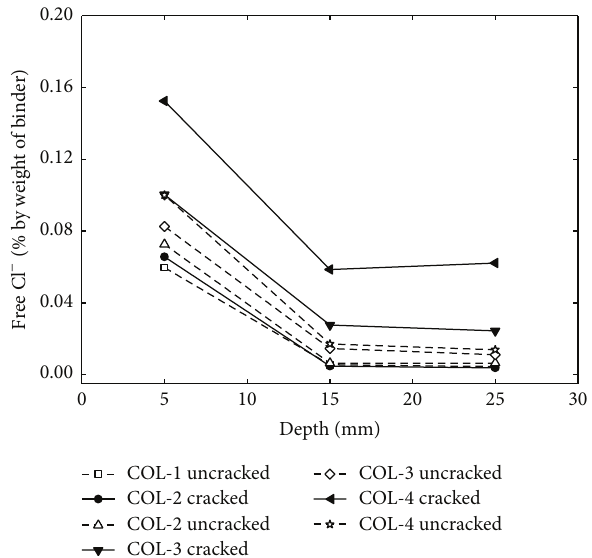
Figure 8: Measured chloride profiles of uncracked and cracked concrete surfaces of column specimens.